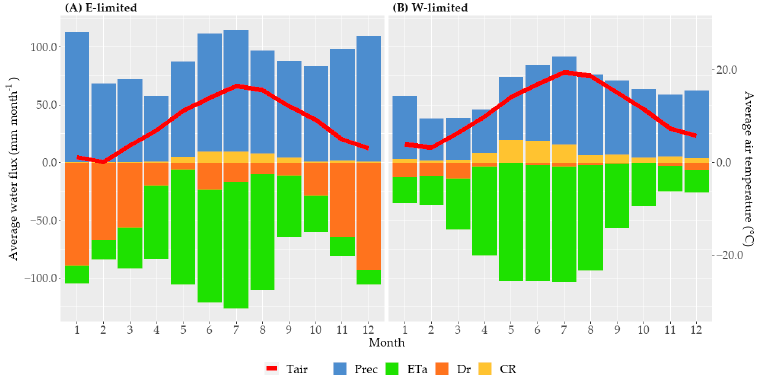
Figure 1. Mean monthly values of the precipitation (Prec), actual evapotranspiration (ETa), drainage (Dr), upward water flow (CR), and average air temperature (T air ) for ( A ) Rollesbroich the energy-limited site (E-limited) and ( B ) Selhausen the water-limited site (W-limited). Positive values represent an input and negative values a loss of water for the system.